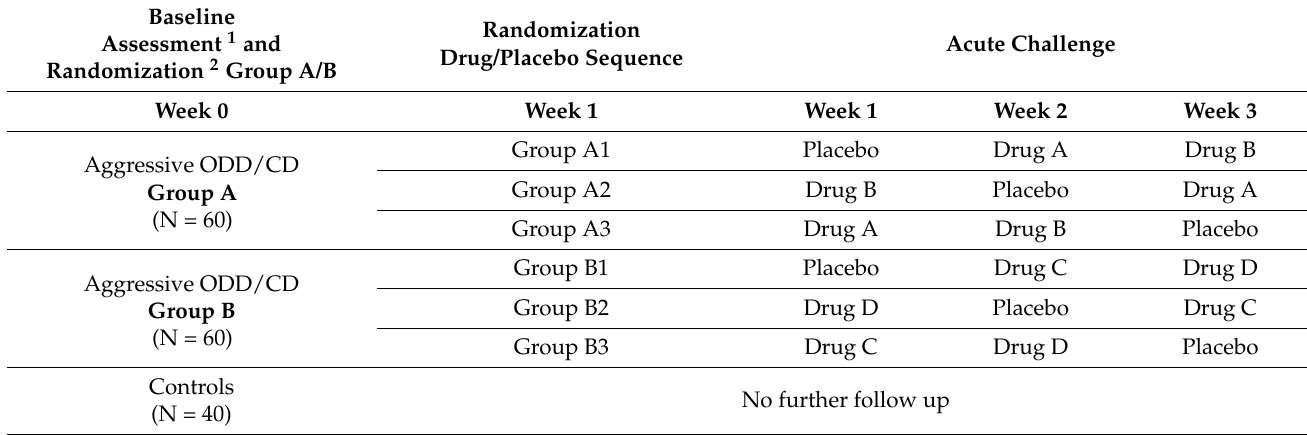
Table 1. Single-blind, placebo-controlled, acute dose, cross-over, randomized medication challenge. Baseline Assessment 1 and Randomization 2 Group